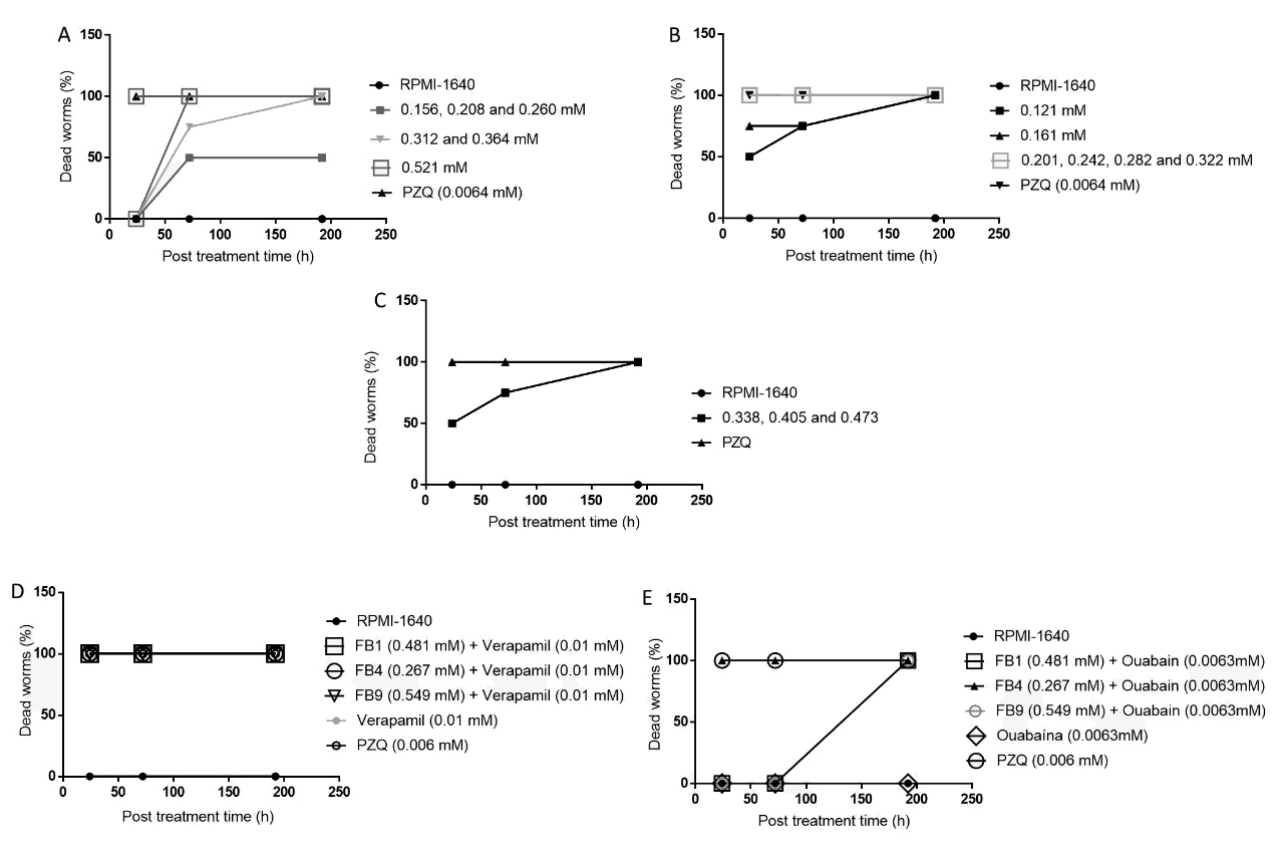
Figure 3. Effect of (A) FB1, (B) FB4, and (C) FB9 on the mortality rate of Schistosoma manson i adult worms in relation to the assessed concentrations (0.156 to 0.521 mM for FB1; 0.121 to 0.322 mM for FB4, and 0.338 to 0.473 mM for FB9) and incubation periods of up to 192 hours. Pharmacological controls were exposed to 0.0064 mM PZQ. Effect of eugenol derivatives on the mortality rate of adult S. mansoni worms in contact with (D) verapamil and (E)